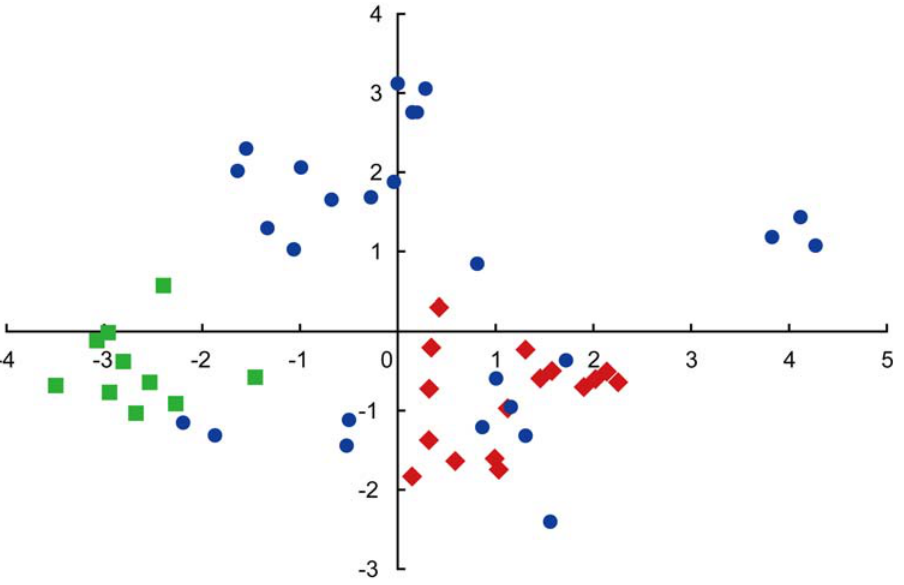
Figure 5. Graph of the first two axes from a principle component analysis. The fifty-two HG7 and HG7 haplotypes based on 14 polymorphic loci were used (Table S3). The first component (x) explains 25.3% and the second (y) 14.5% of the total variation. Circles, squares, and diamonds indicate the western HG7 haplotypes, eastern HG7 haplotypes, and HG16 haplotypes, respectively.